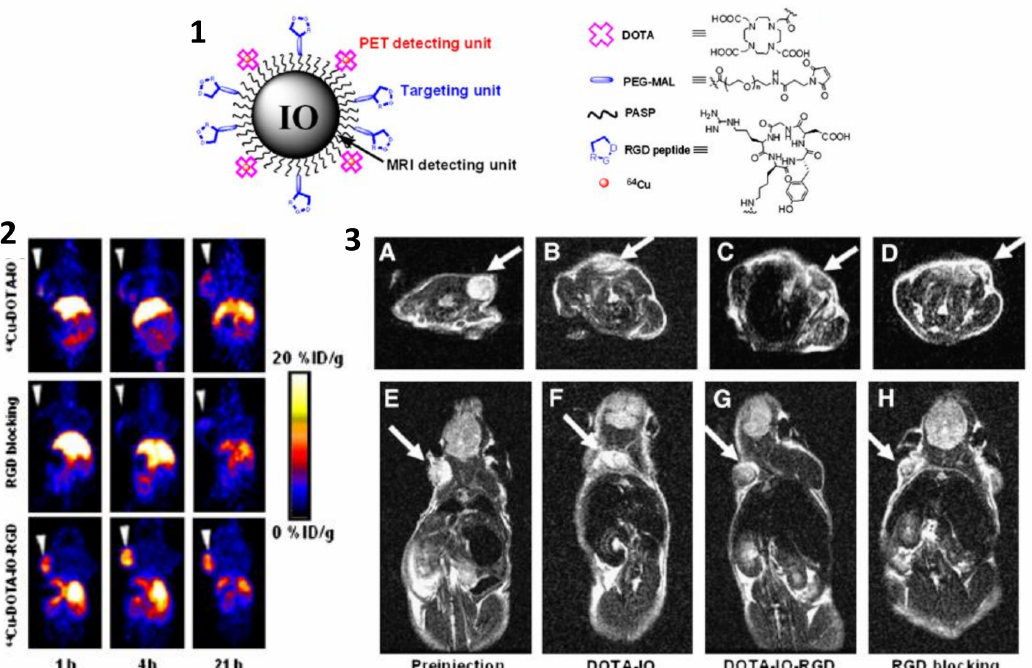
Figure 12. ( 1 ) Illustration of PET/MRI probe based on iron oxide nanoparticle. ( 2 ) Decay-corrected whole-body coronal PET images of nude mouse bearing human U87MG tumor at 1, 4, and 21 h after injection of different PET/MRI probes based on iron oxide nanoparticles. ( 3 ) T2-weighted MR images of nude mice bearing U87MG tumor before injection of iron oxide nanoparticles ( A , E ) and at 4 h after tail-vein injection of DOTA-IO ( B , F ), DOTA-IO-RGD ( C , G ), and DOTA-IO-RGD with blocking dose of c(RGDyK) ( D , H ). Figure adapted from [103], Copyright 2008 Society of Nuclear Medicine,